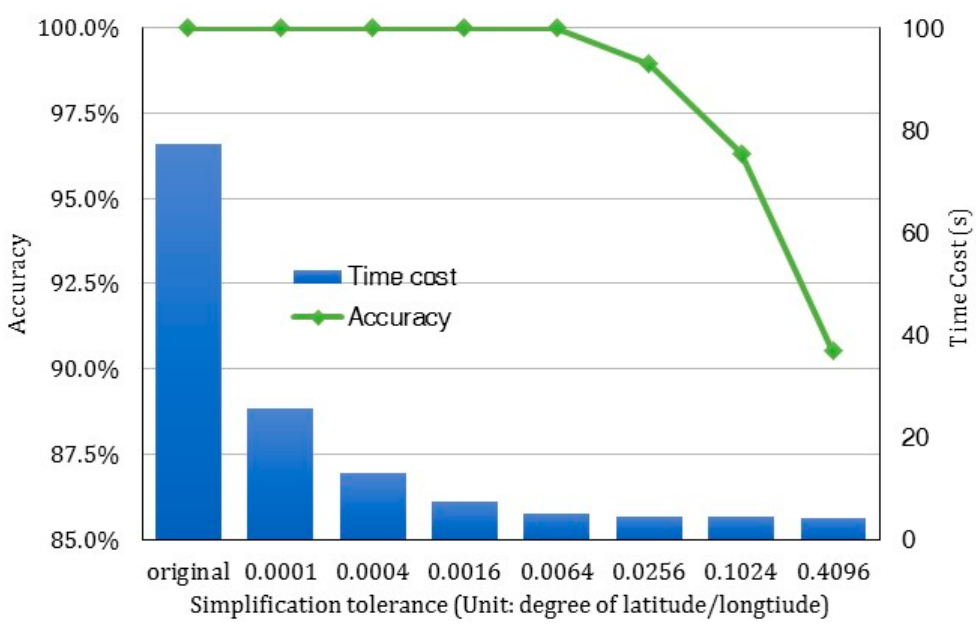
Figure 8. A comparison between time cost and data accuracy in spatial filtering after applying simplification to the spatial boundary.